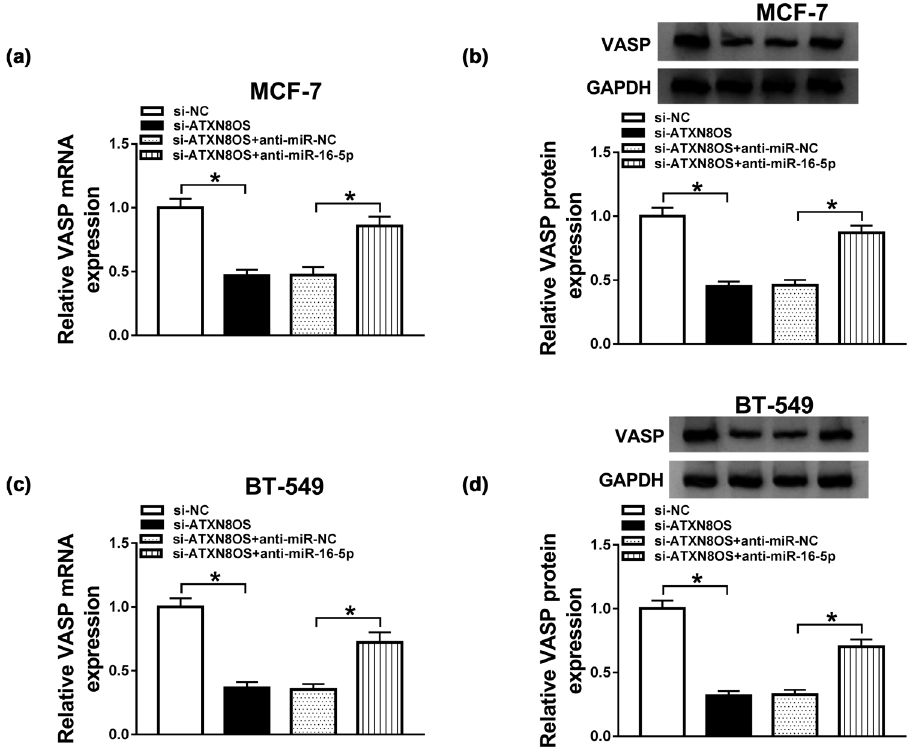
Figure 7: ATXN8OS acted a ceRNA of miR - 16 - 5p to regulate VASP expression. MCF - 7 ( a and b ) and BT - 549 ( c and d ) cells were transfected with si - NC, si - ATXN8OS, si - ATXN8OS + anti - miR - NC, or si - ATXN8OS + anti - miR - 16 - 5p, followed by the evaluation of VASP mRNA and protein levels by qRT - PCR and western blot, respectively. * P <